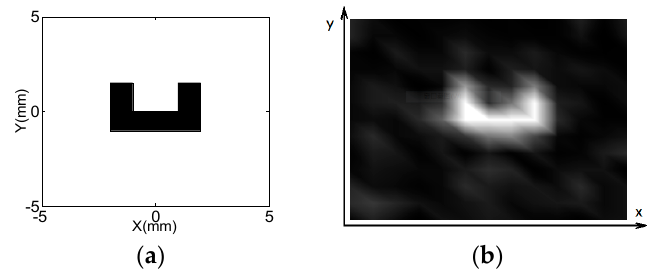
Figure 7. ( a ) Letter C image cropped from a natural rubber was utilized as a simple model; ( b ) 2D images of the model of the letter C obtained by applying the CPMG-CP sequence. The reconstructed image almost shows the structure of the model.